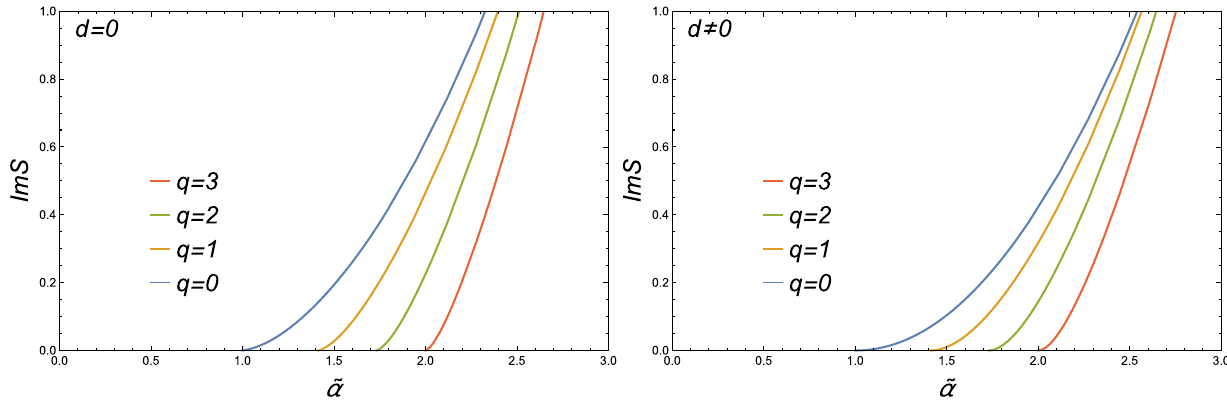
Fig. 8 The imaginary part of the effective action as a function of ˜ α = E / E c ( 0 ) in the D(-1)–D3 background. We have set b = 1